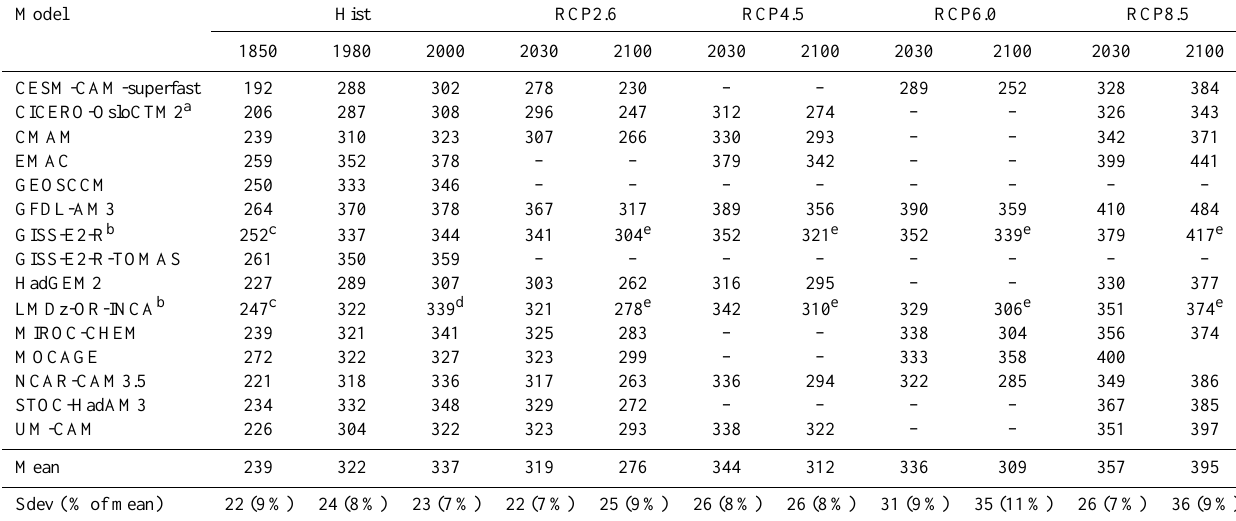
Table 1. Tropospheric ozone burdens (Tg) for the individual models and the ACCMIP mean. Also shows which simulations and time slices are available from each model for this study. Not all relevant variables are available for each model/time